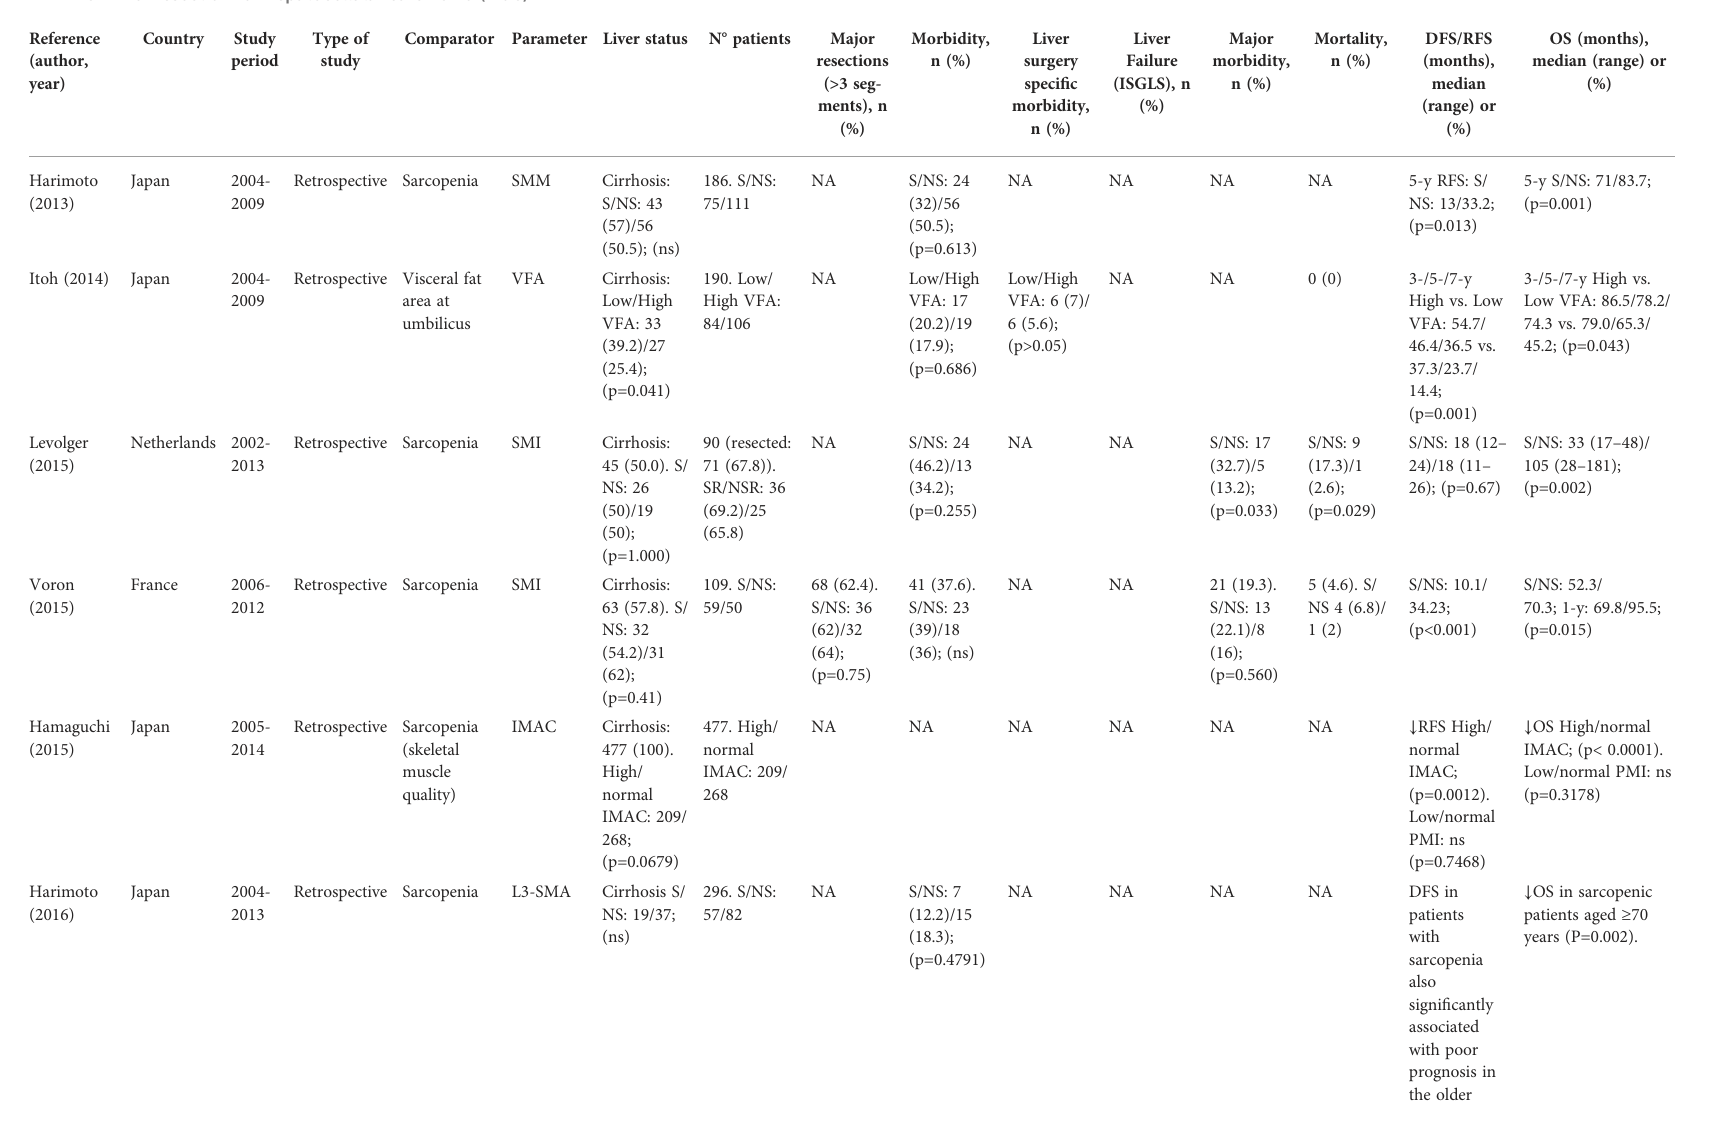
TABLE 3 Liver resection for hepatocellular carcinoma